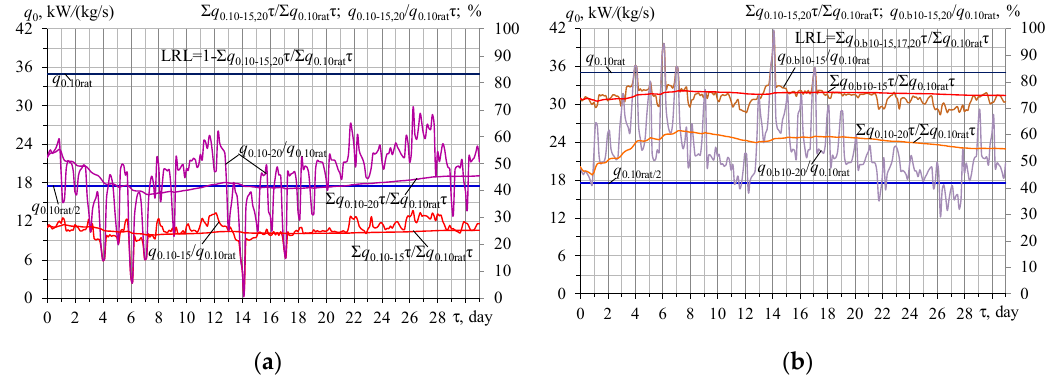
Figure 6. Relative values of refrigeration capacities q 0.10-15,20 / q 0.10rat for further conditioning of air from 15 ° С and 20 ° С to 10 ° С , and corresponding relative summarized refrigeration energy consumed ∑ ( q 0.10-15,20 τ )/ ∑ ( q 0.10rat τ ) ( a ), relative residual booster refrigeration capacities q 0.b10-15,20 / q 0.10rat and corre- sponding relative summarized booster refrigeration energy ∑ ( q 0.b10-15,20 τ )/ ∑ ( q 0.10rat τ ) ( b ): ( a )— q 0.10-15,20 ; ( b )— q 0.b10-15,20 .